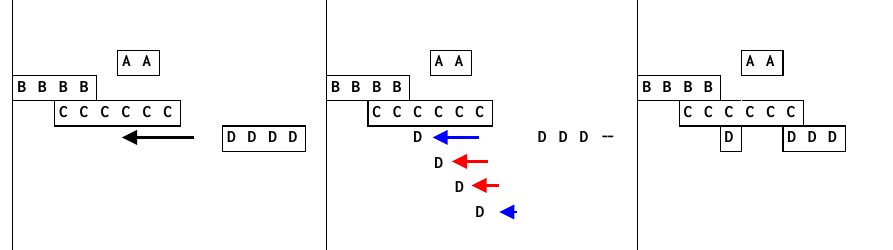
Fig. 5. Opportunity for Backward Movement (Left Gantt); Activity D is Not Allowed Shift Back to LF(B)+2 (Middle Gantt); Activity “D” Rescheduled to LF(A)+1 instead (Right Gantt)